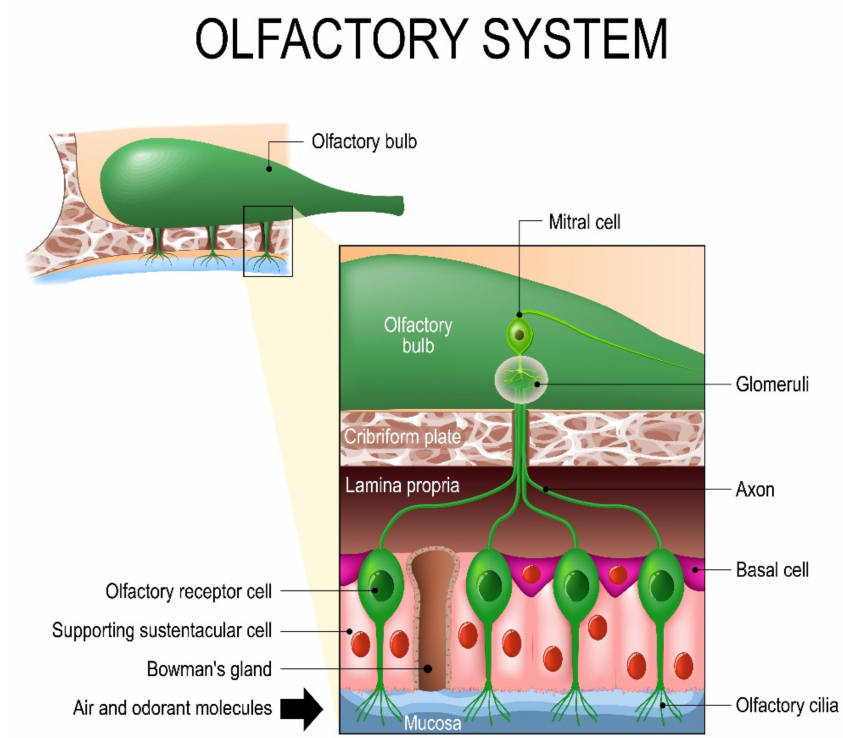
Figure 1. Olfactory epithelium with sustentacular supporting